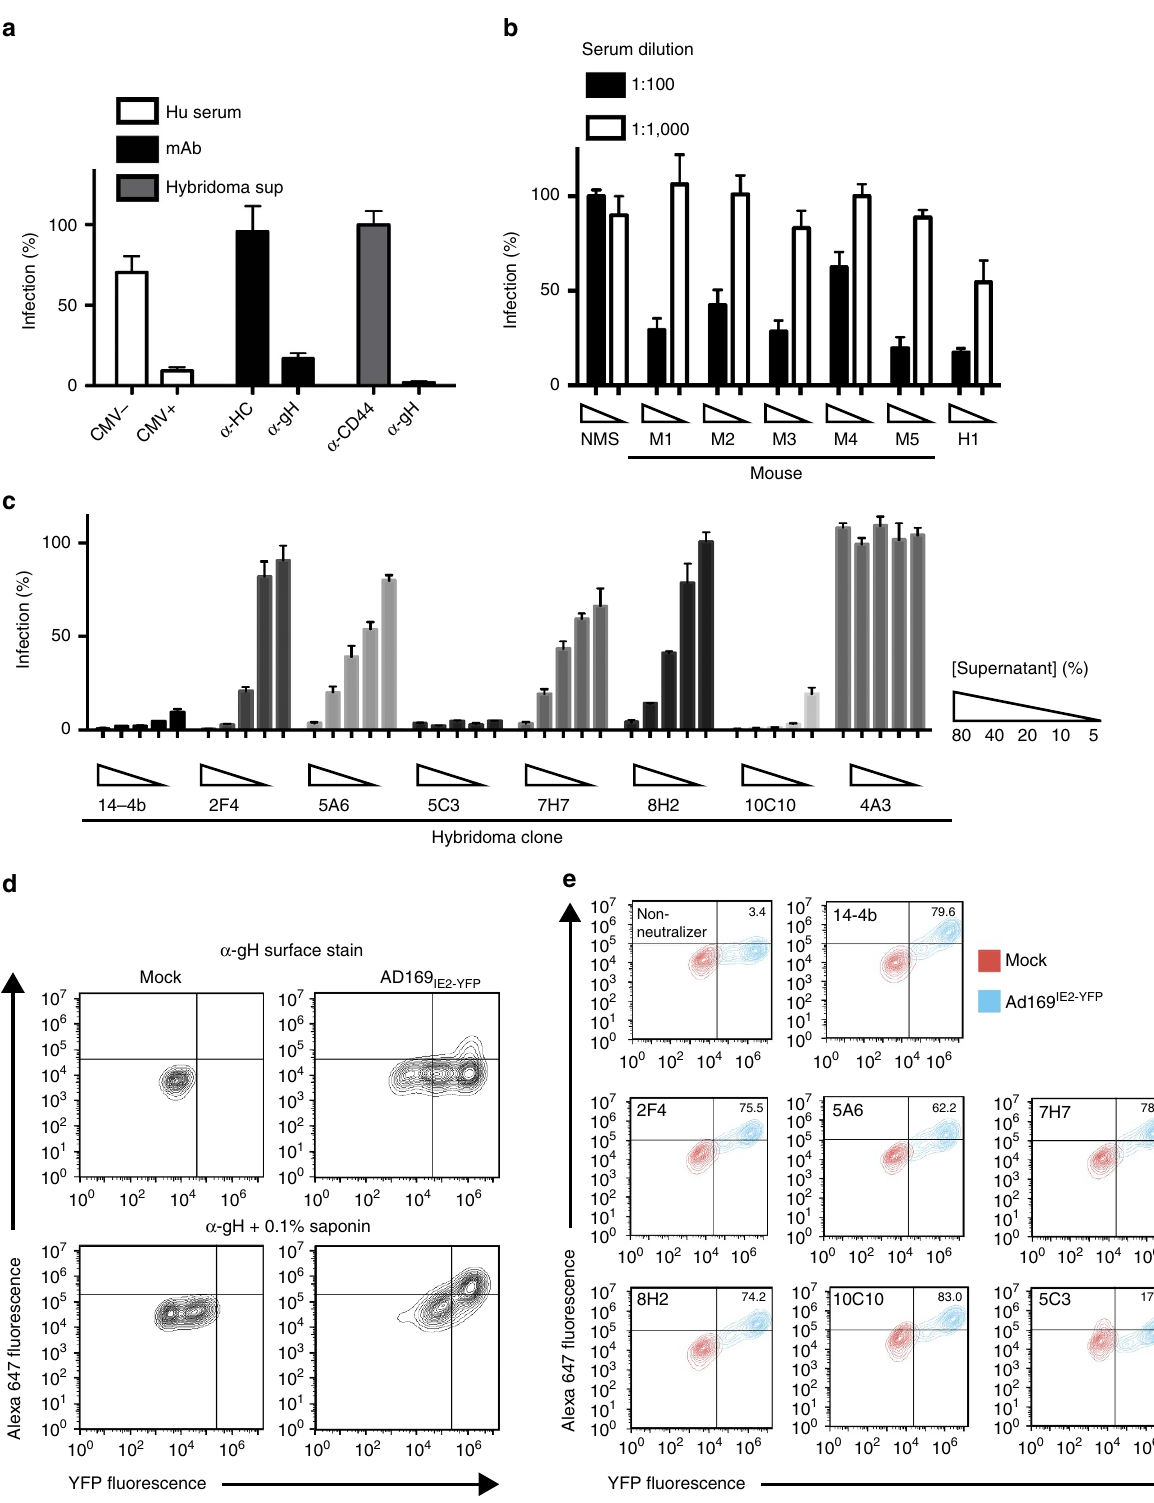
Figure 1 | Identification of CMV-neutralizing mAbs using a HTN assay. ( a ) Human serum, purified mAb (anti-MHCI heavy chain (HC) mAb (HC-10), anti-gH mAb 14-4b) and hybridoma supernatant were tested in a HTN assay for their ability to block infection of fibroblasts by AD169 IE2-YFP . ( b ) Serum from mice inoculated with AD169 was tested for its ability to neutralize AD169 IE2-YFP infection at 1:100 (black bars) or 1:1000 (white bars). Normal mouse serum (NMS) or CMV þ human serum (H1) were used as controls. ( c ) Hybridoma supernatant from 6 CMV-neutralizing clones was tested in 5-point dilutions (5–80%) for their ability to inhibit AD169 IE2-YFP infection. Supernatant from the neutralizing anti-gH mAb 14-4b and supernatant from the non- neutralizing hybridoma clone 4A3 were utilized as controls. ( d ) MRC5 cells infected with AD169 IE2-YFP were exposed to anti-gH (14-4b) flow cytometry staining without (top row) or with (bottom row) permeabilization with saponin. ( e ) Mock-infected MRC5 cells (red) or infected with AD169 IE2-YFP (blue) were permeabilized and then exposed to hybridoma supernatant from the CMV-neutralizing clones followed by detection with flow cytometry. Experiments for ( a – c ) were performed in technical triplicate and s.d. is